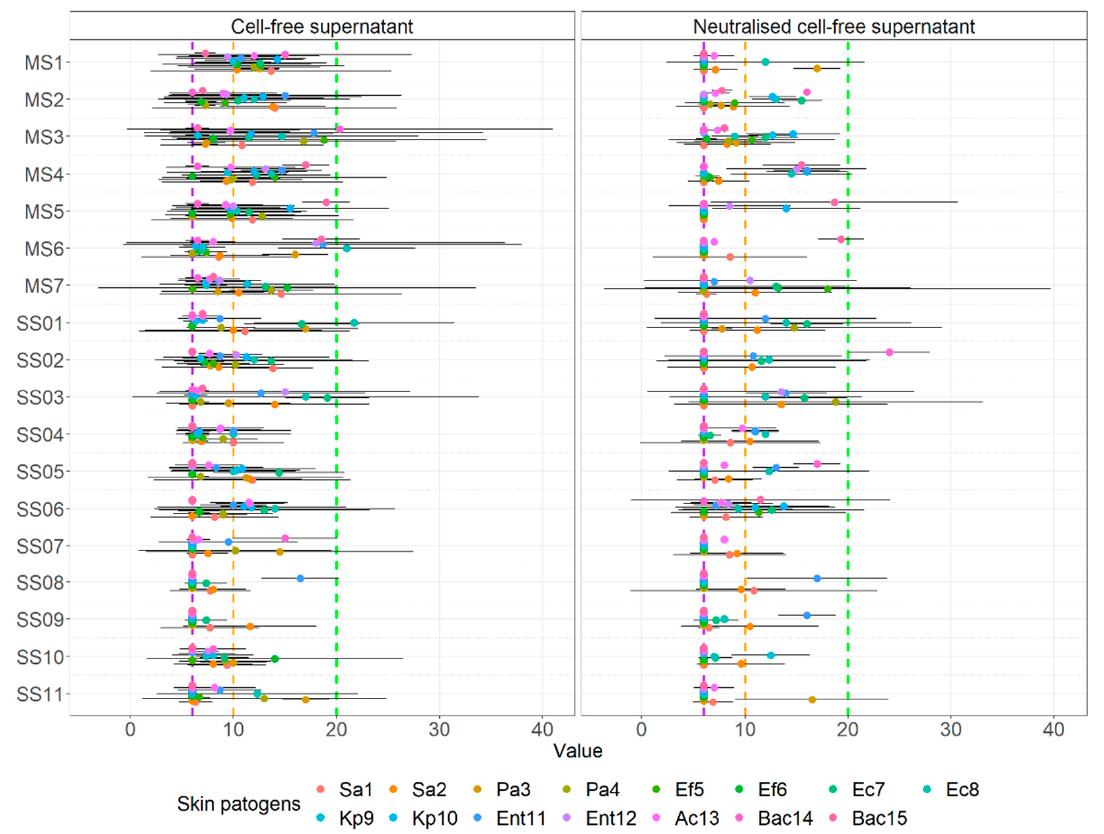
Figure 5. Means of inhibition zone together with 95% CI of various cell-free supernatants of probiotics and other beneficial microbes against clinical skin pathogens using the agar well diffusion assay.